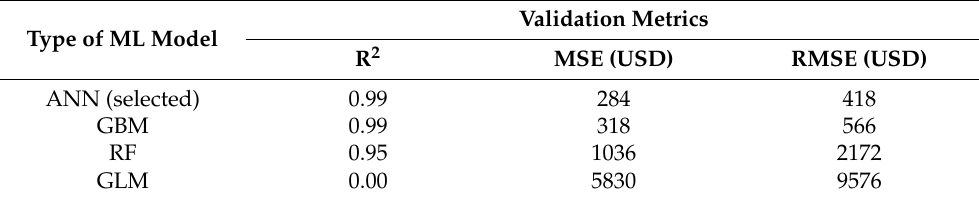
Table 4. Validation metrics for rebate ML model selection.